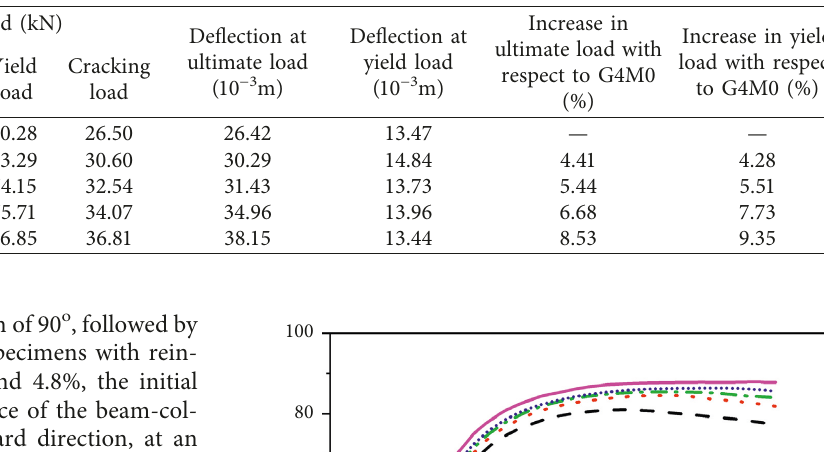
Table 16: Load-deflection response of specimens with different thicknesses of